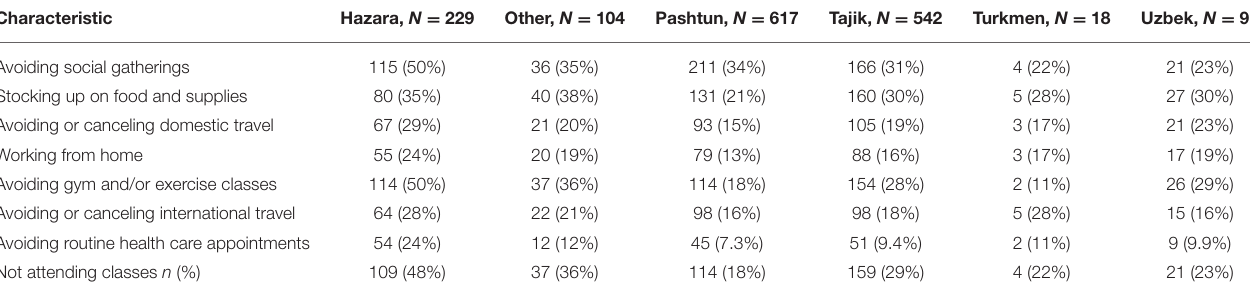
TABLE 2 | Lifestyle changes since the US withdrew from Afghanistan.